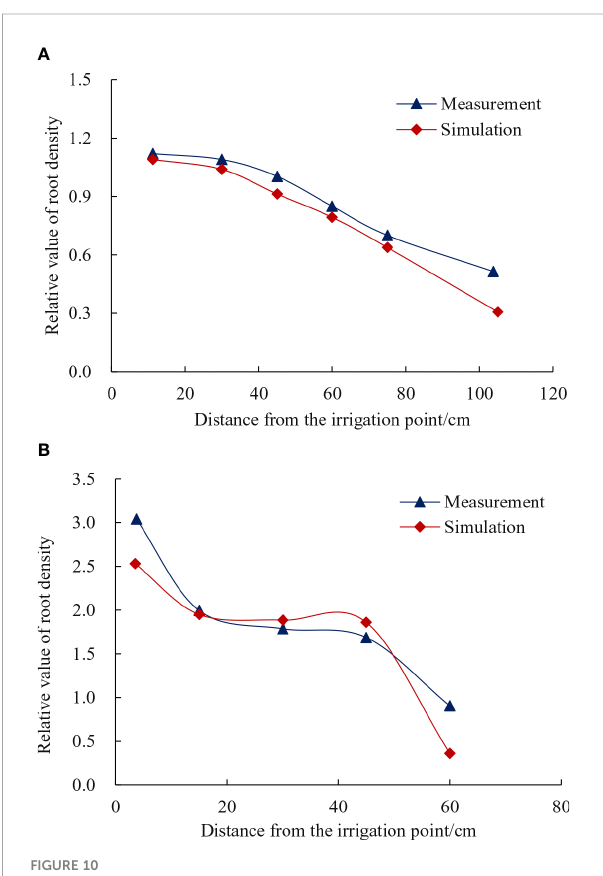
FIGURE 10 Comparison of relative values of root length density. (A) 30-cm planting spacing. (B) 15-cm planting